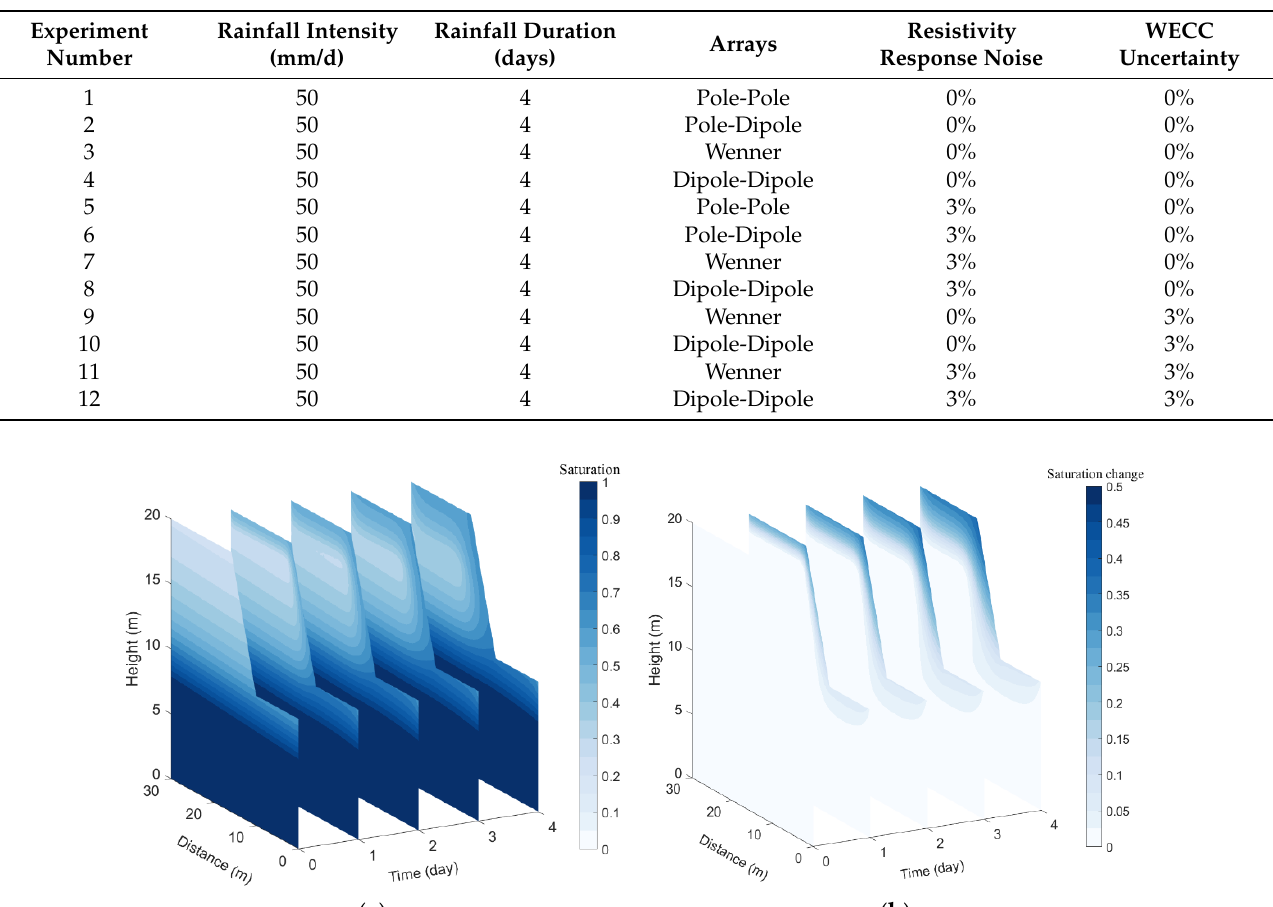
Table 2. Details of experimental design.